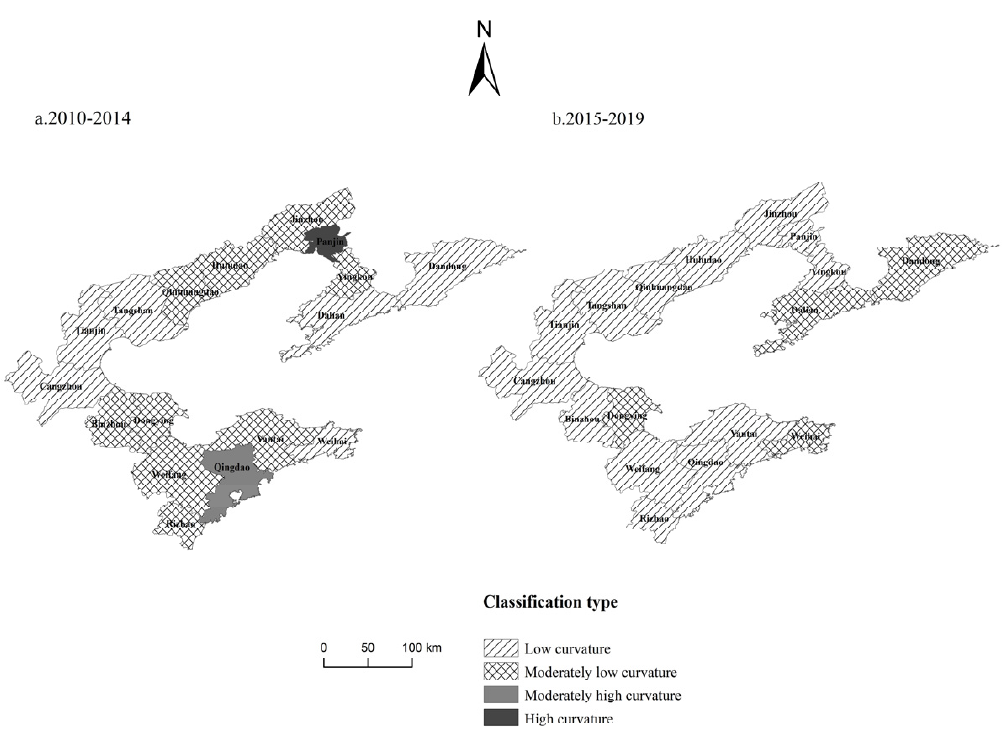
Figure 6. Tortuosity of the local indicators of the spatial association time path. Source: own study.